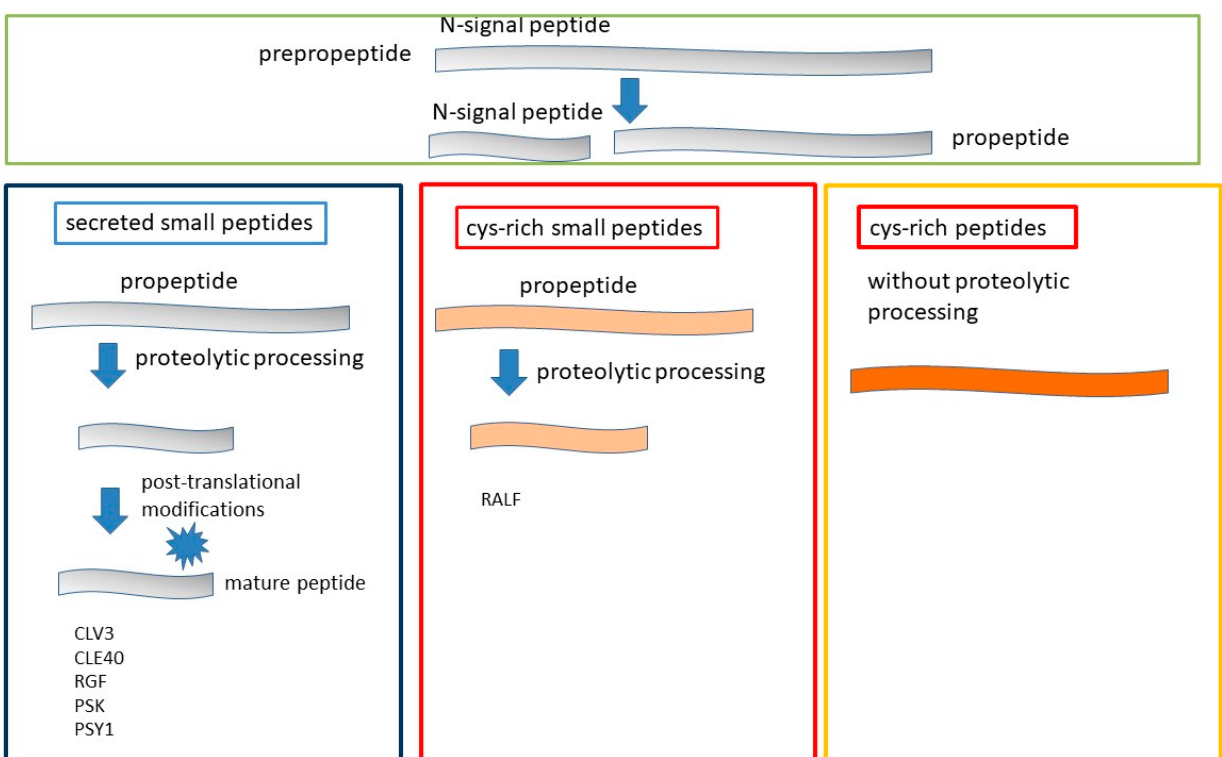
Figure 1. Three groups of secreted peptides classified according to their structural characteristics. The first group of peptides is small peptides with post-translational modifications. The other two groups are cis-rich peptides with and without proteolytic processing.